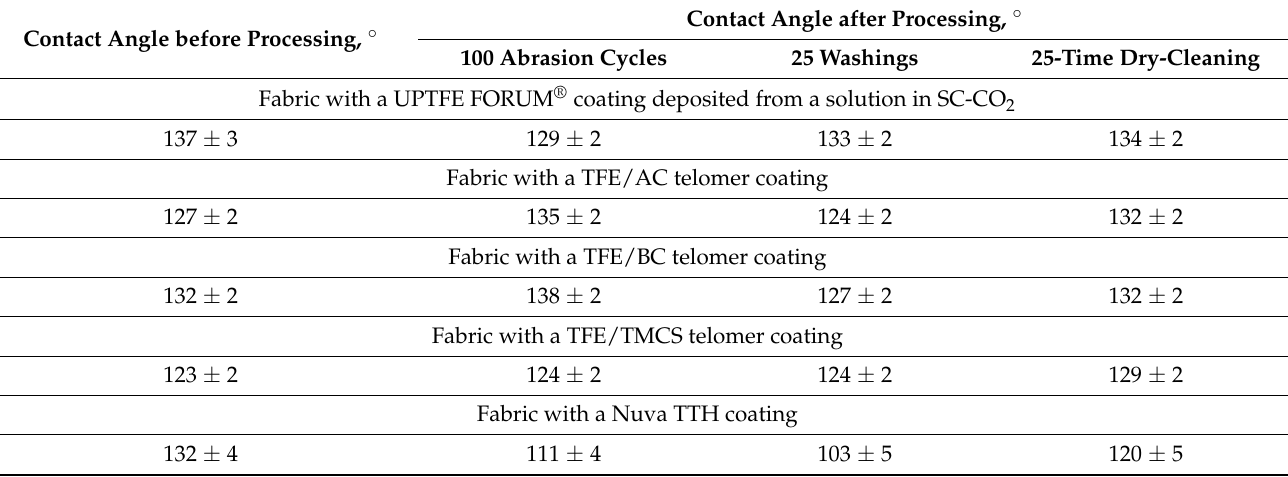
Contact Angle before Processing,